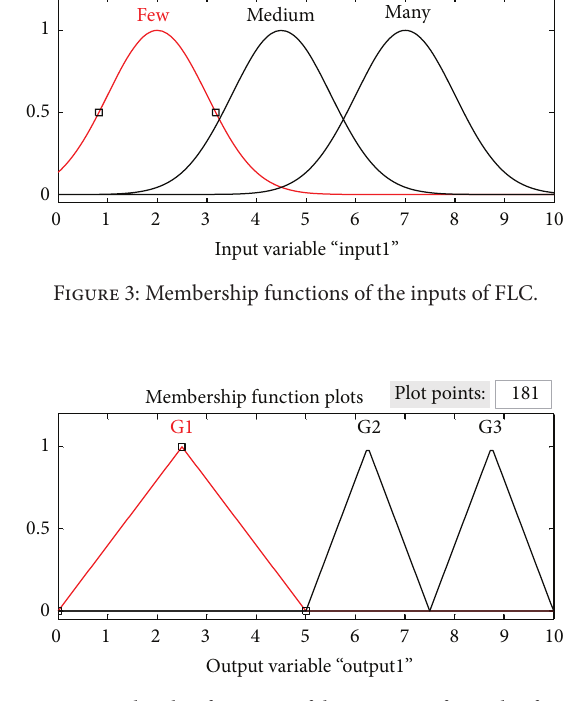
Figure 4: Membership functions of the output surface rule of